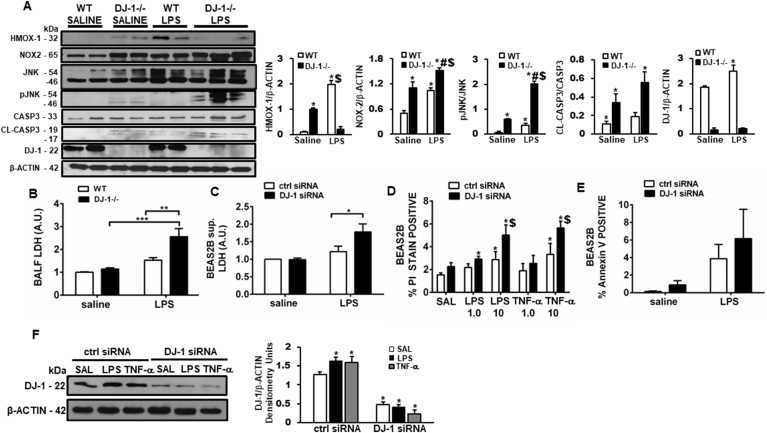
Loss of DJ-1 leads to oxidative stress-induced enhanced cell death. A) Western blots showing protein expression of NRF2, HMOX1, NADPH OXIDASE 2 (NOX2), JNK, pJNK, caspase 3 (CASP3), cleaved caspase 3 (CL-CASP3), DJ-1 and B-ACTIN. Densitometry measurements (protein/β-actin) mean + SEM. n = 2–3. *p < 0.05 vs. WT saline, #p < 0.05 vs. WT LPS, $p < 0.05 vs. DJ-1−/− saline. Cell death analysis using Lactate dehydrogenase (LDH) release in B) BALF (n = 6–8 animals each) and C) supernatants of Beas-2b cells treated with 50 nM control siRNA or DJ-1 siRNA (n = 3 independent experiments. D) Propidium Iodide (PI) staining (n = 3 independent experiments) and E) Annexin V staining in control and DJ-1 siRNA treated Beas-2b cells (n = 1 independent experiment). *p < 0.05, **p < 0.01, ***p < 0.001, two-way ANOVA.